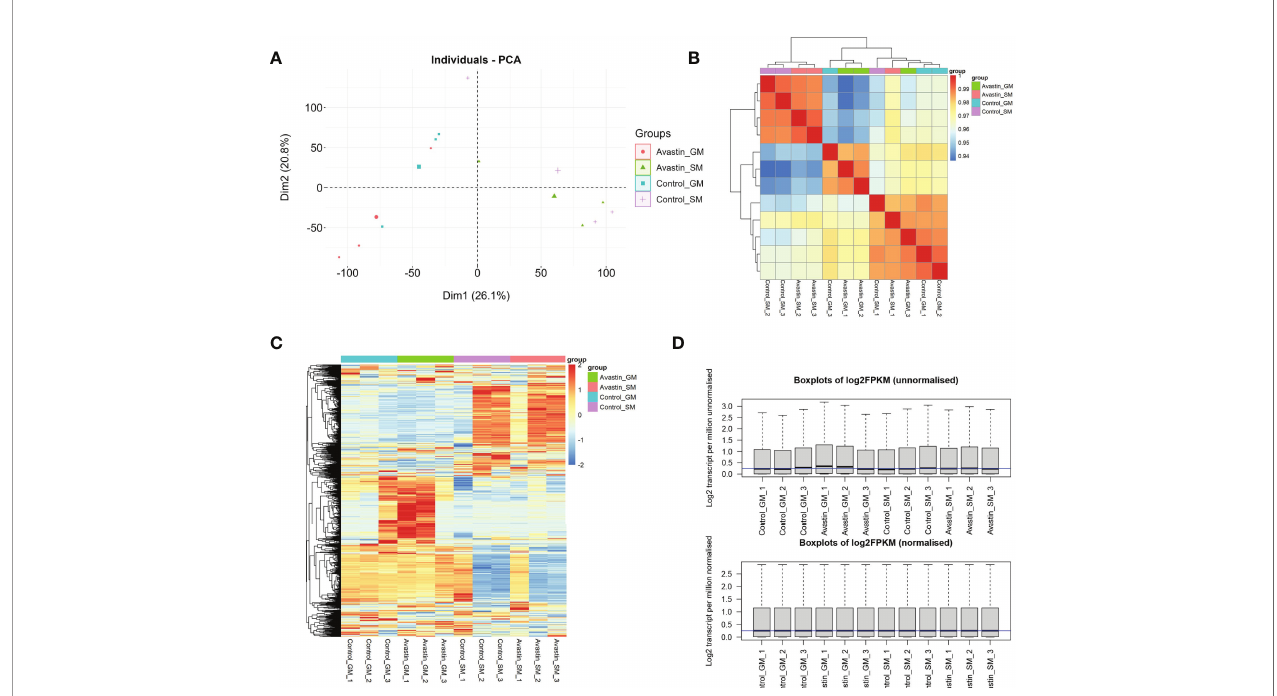
FIGURE 1 | Validation of sequencing data. (A) PCA analysis of data distribution in 12 samples; (B) correlation analysis of genes in each sample; (C) heat map of gene distribution in samples; (D) normalization results of